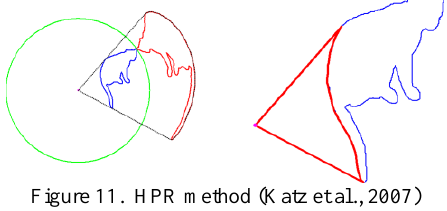
Figure 11. HPR method (Katz et al.,